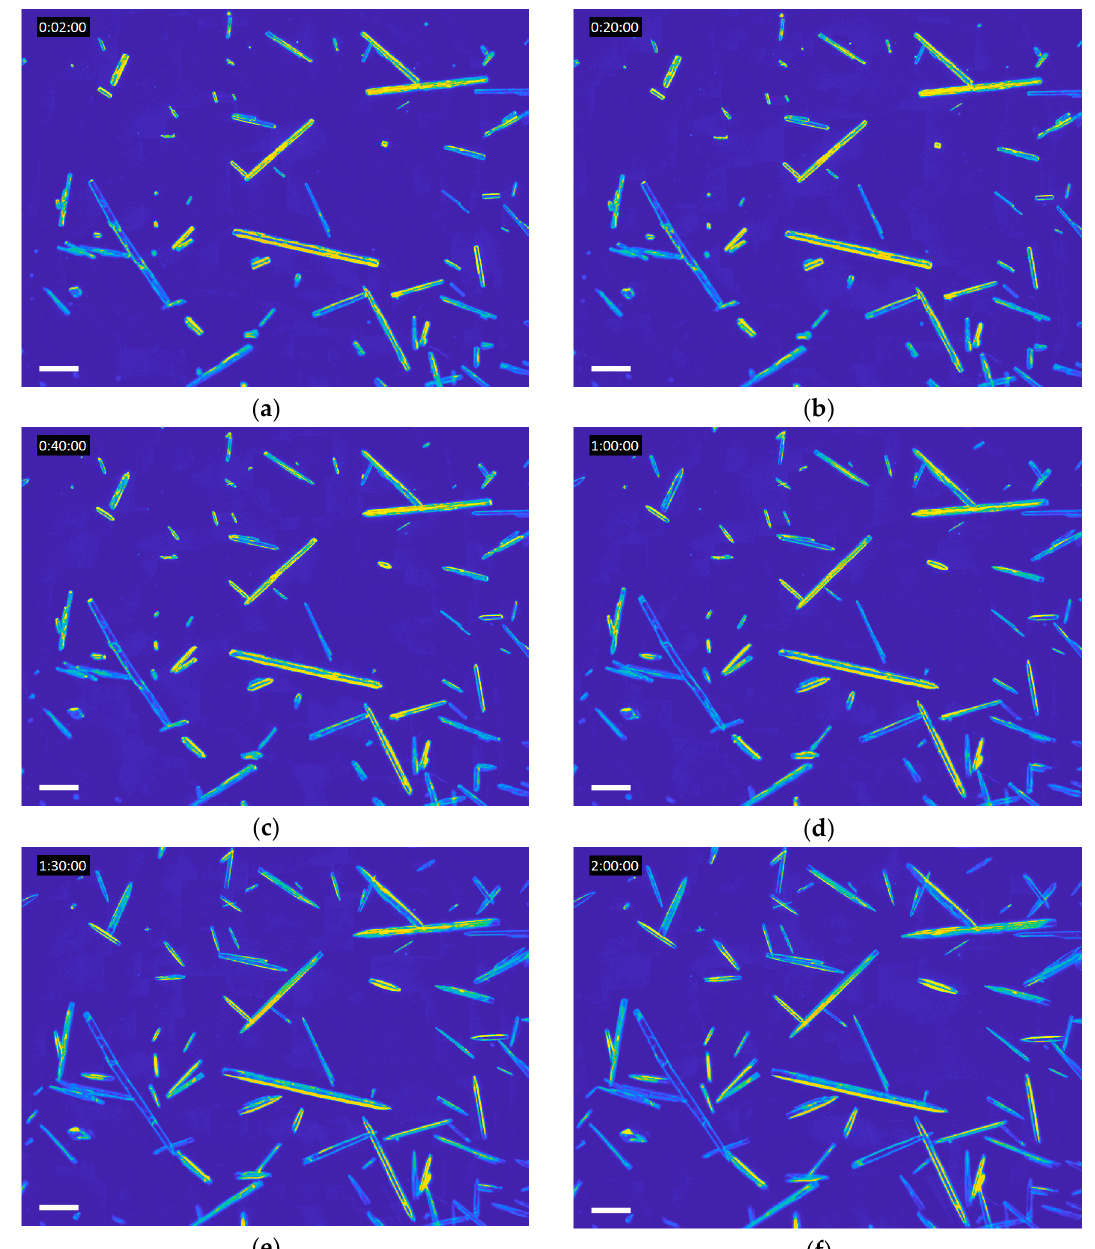
Figure 1. Microscope images of ampicillin trihydrate, colorized to enhance contrast. The scale-bar is 100 µ m: ( a – f ) images taken at 2, 20, 40, 60, 90, and 120 min, respectively.